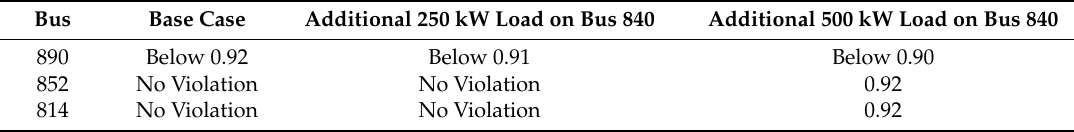
Table 4. Case 1 Maximum Additional kW on Bus 840 during Peak Hours.